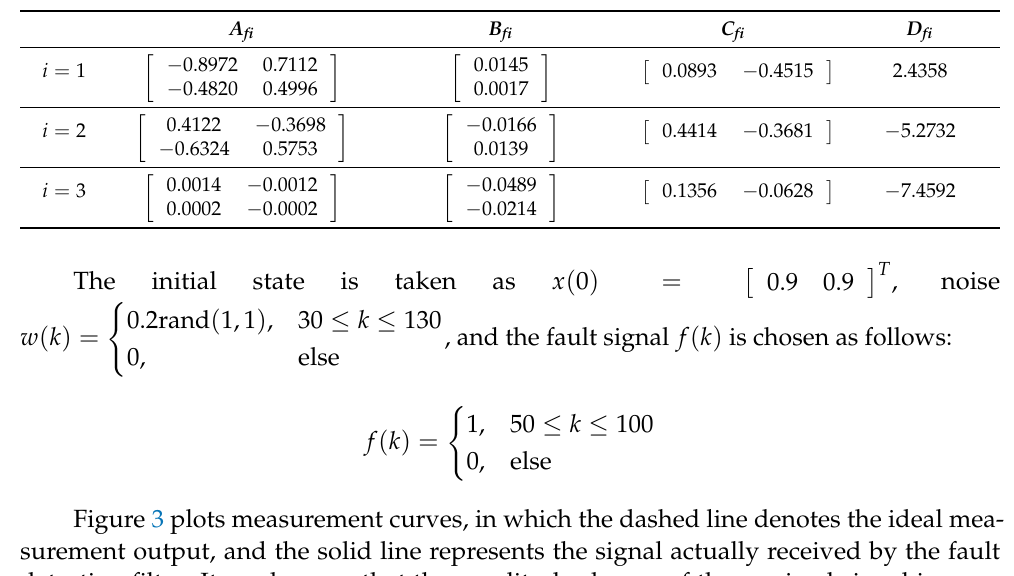
Table 1. The computed gains of the fault detection